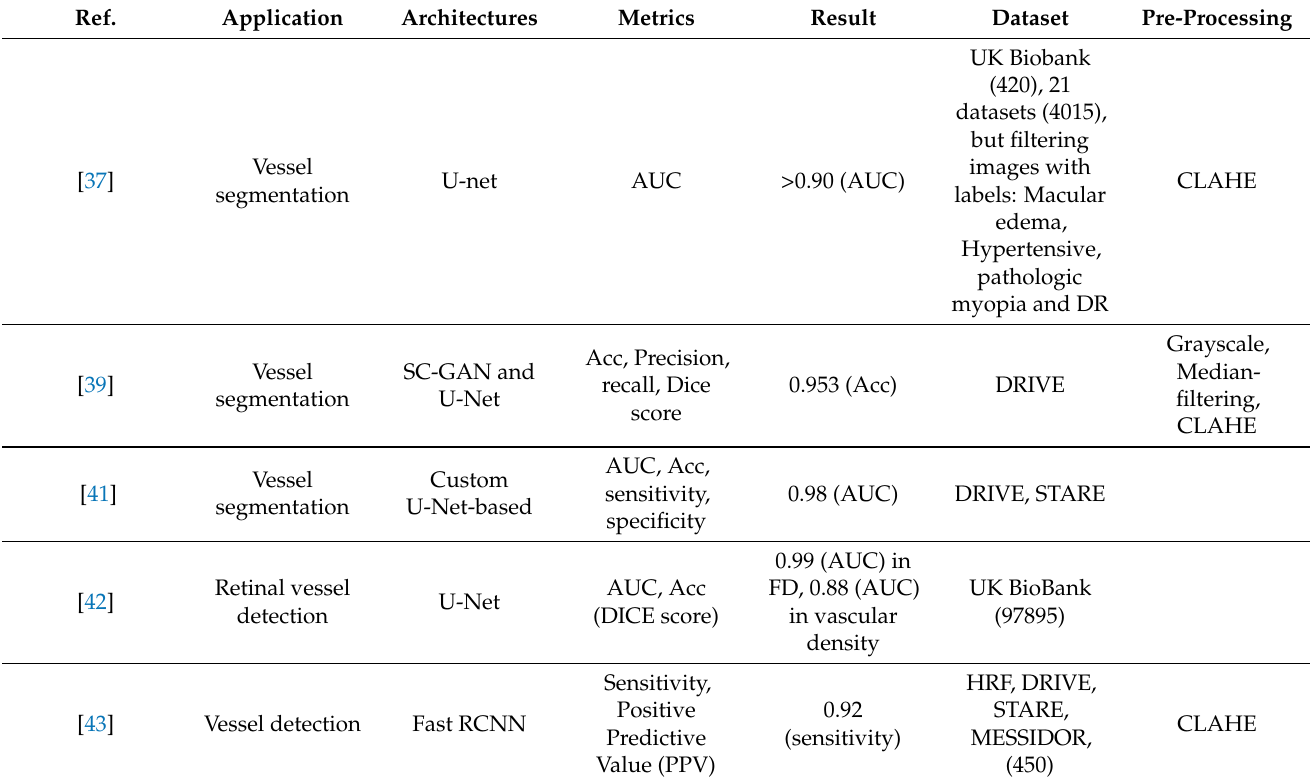
Table 4. Automated methods for extracting biomarker characteristics.